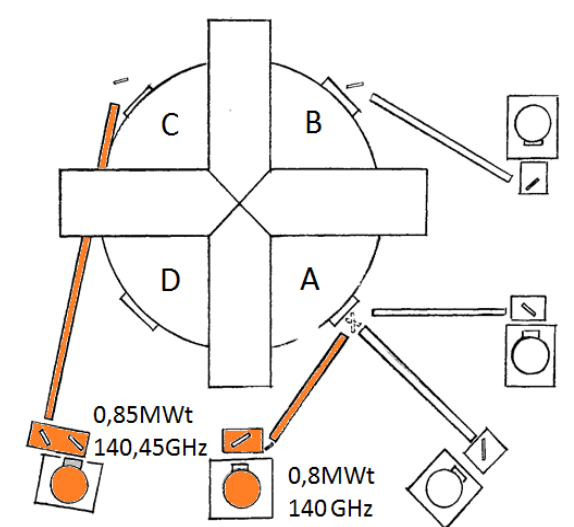
Fig. 3. Major radius R=1,5m, W-limiter a=0,3m. “A” and